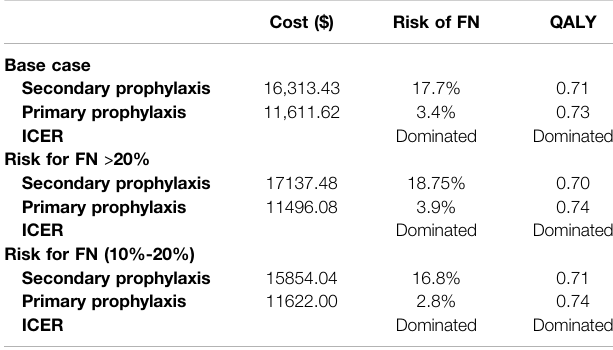
TABLE3| Basecaseandsubgroupscost-effectivenessresultsforPEG-rhG-CSF as primary versus secondary